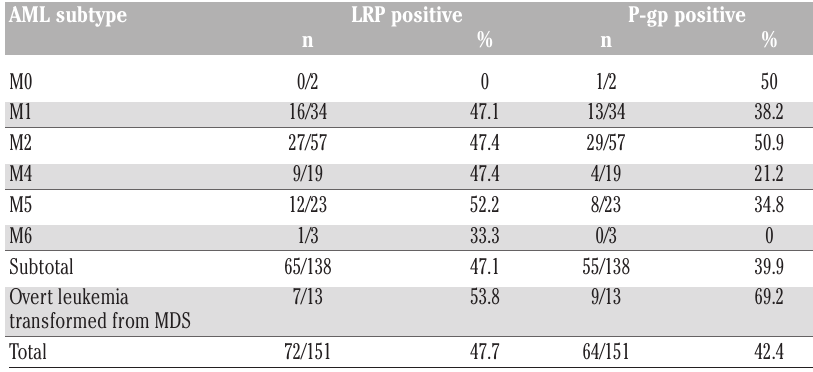
Table 1. Lung resistance-related protein and P-glycoprotein expression in acute myeloge- nous leukemia